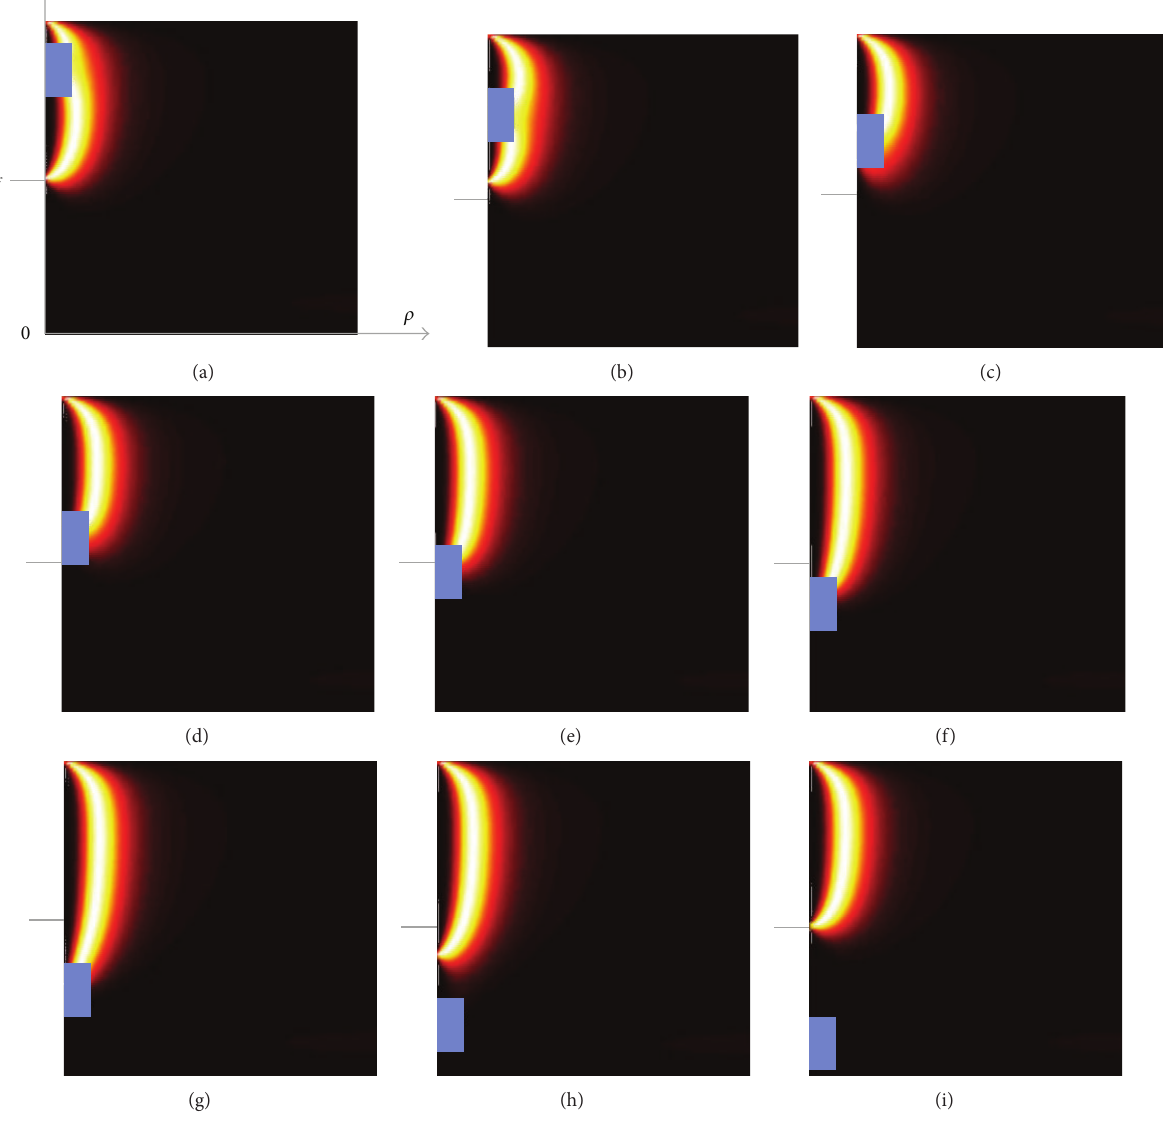
Figure 2: Two-dimensional 𝛽 2 (𝜌,𝑧) plot for different positions of the NP enforcing melted local ordering. One sees that NP affects position (they attract each other) of the melted finger-tip if they are close enough. Black colour indicates uniaxial ordering. Increasingly white colour reveals increasing degree of biaxiality. The distance ℎ − 𝑧 𝑓 describes the length of the finger-tip in absence of the